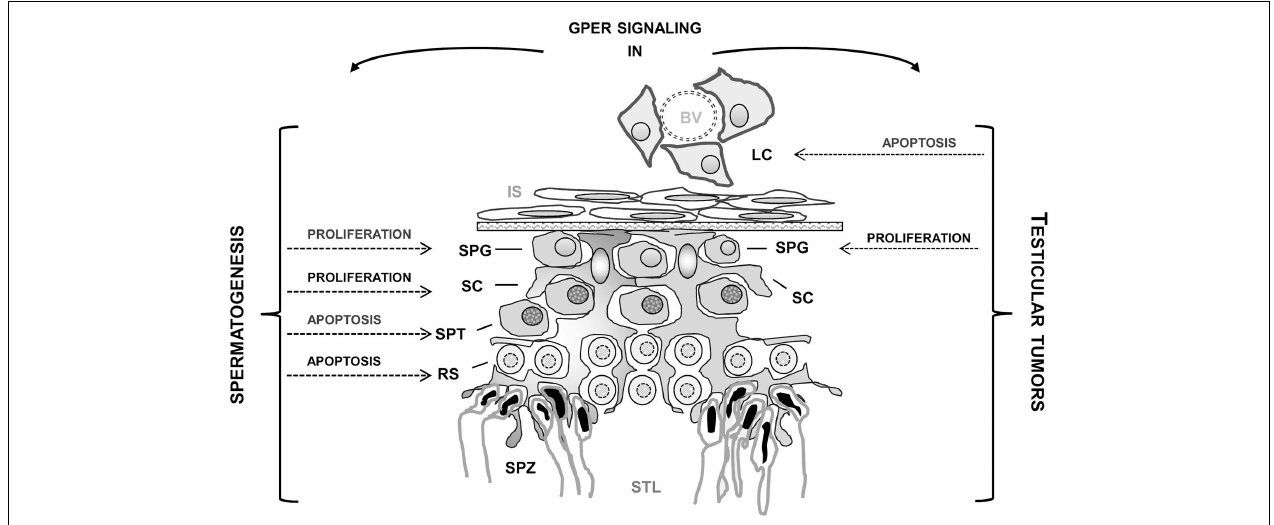
FIGURE 1 | Effects mediated by GPER activation in normal and tumoral testicular cells . BV, blood vessel; LC, Leydig cells; IS, interstitial space; SC, Sertoli cells; SPG, spermatogonia; SPT, spermatocytes; RS, round spermatids; SPZ, spermatozoa; STL, seminiferous tubule lumen.